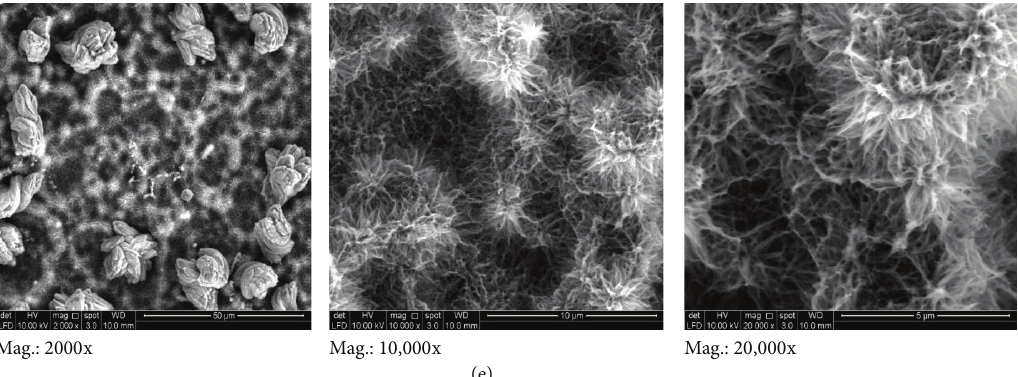
Figure6:(a)–(e)ShowingSEMmicrographsoftheHAcoatingonCPTisurfacesonthethird,fourth,fifth,sixth,andseventhday,respectively, at different magnifications.